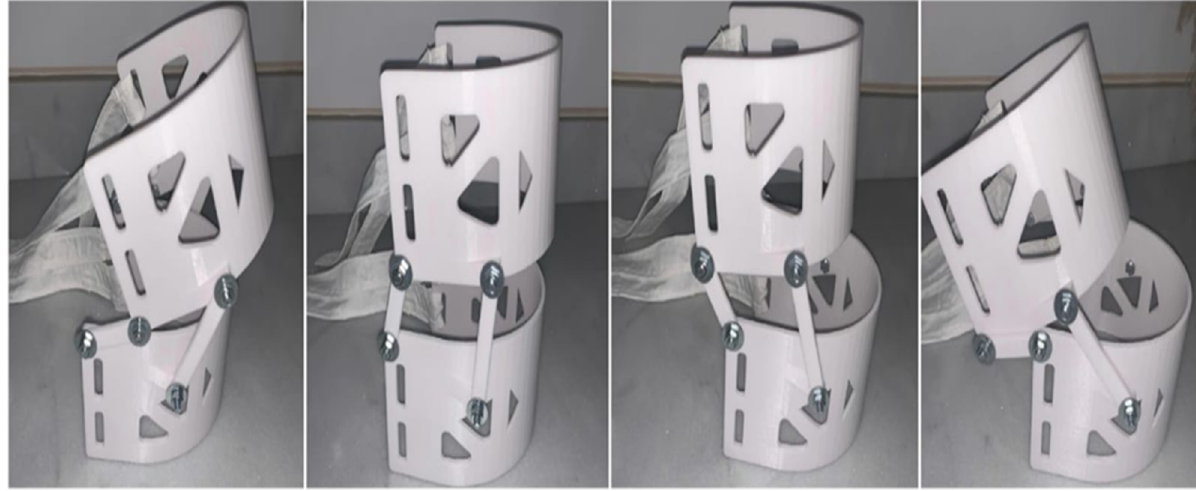
Figure 9: Swing phase and the stance phase.